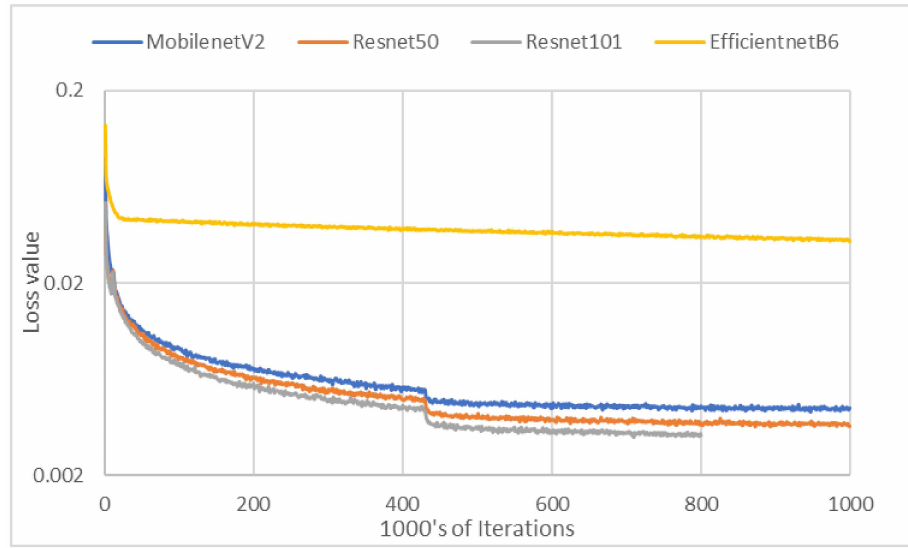
Figure A1. Training iteration